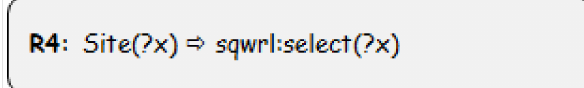
Figure 5. Rule form.